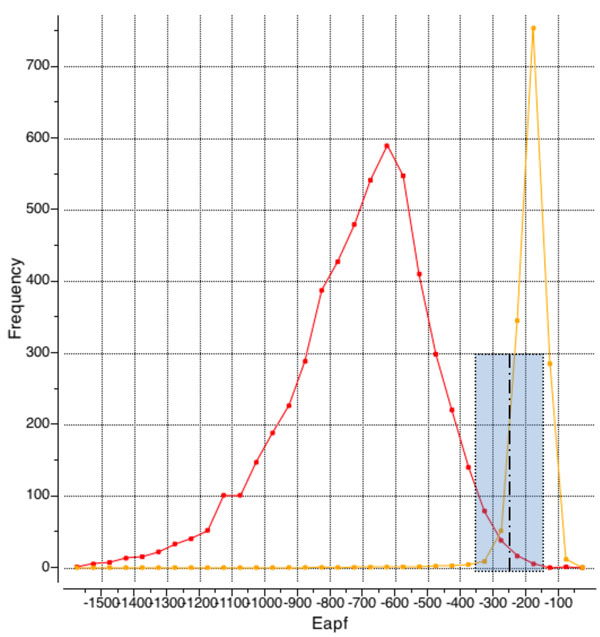
Histograms of optimal EAPF for random site pairs (orange) and identical pairs (red).